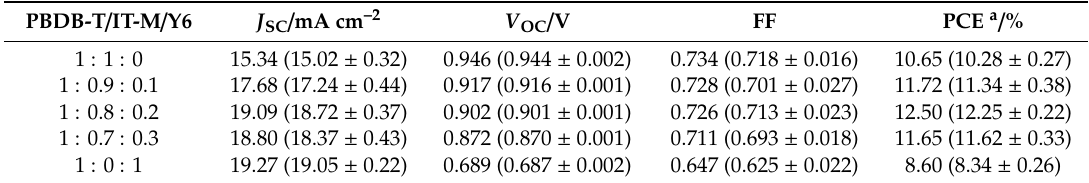
Table 1. Photovoltaic parameters of PBDB-T / IT-M / Y6 ternary blend polymer solar cells with di ff erent compositions.